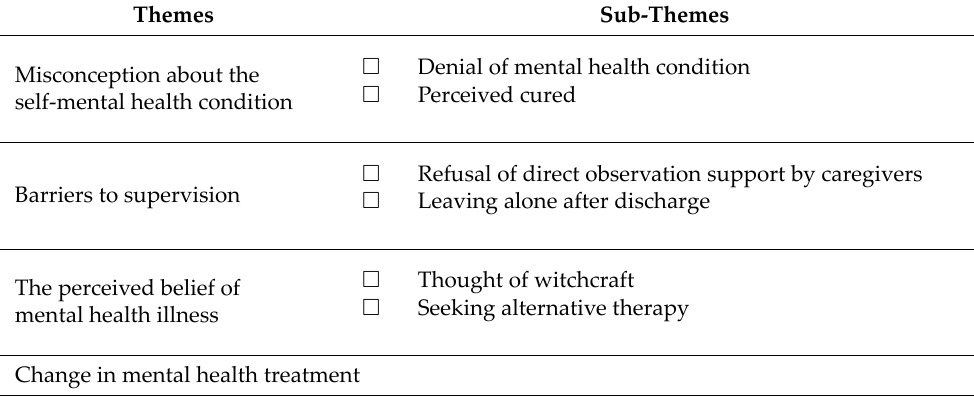
Table 2. Summary of themes and